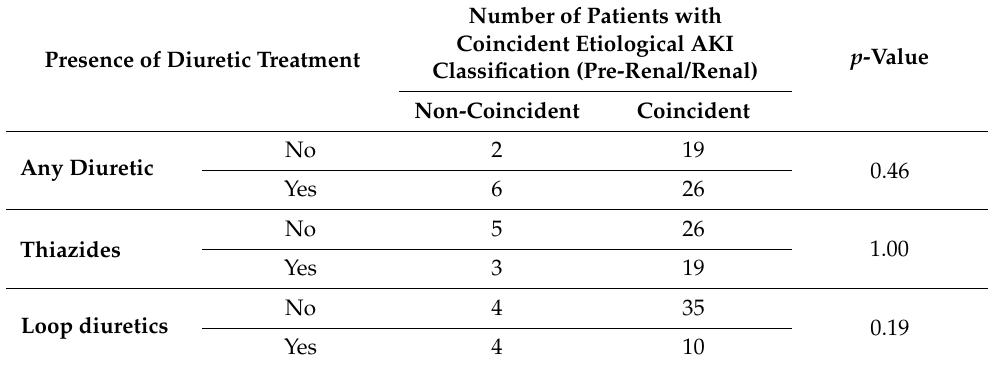
Table 3. Contingency tables showing no statistically significant impact of the diuretic treatment on the etiological classification of